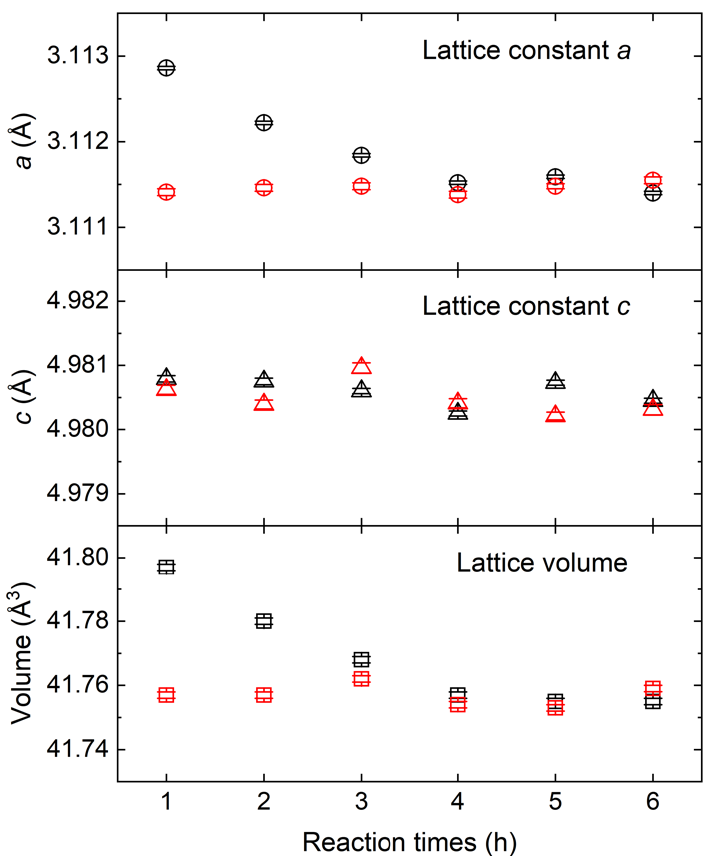
Figure 2. Changes in lattice parameters ( a , c ) and unit cell volume of AlN samples with the reaction time. The lattice constants of the AlN samples before and after sintering are shown in black and red open symbols, respectively.